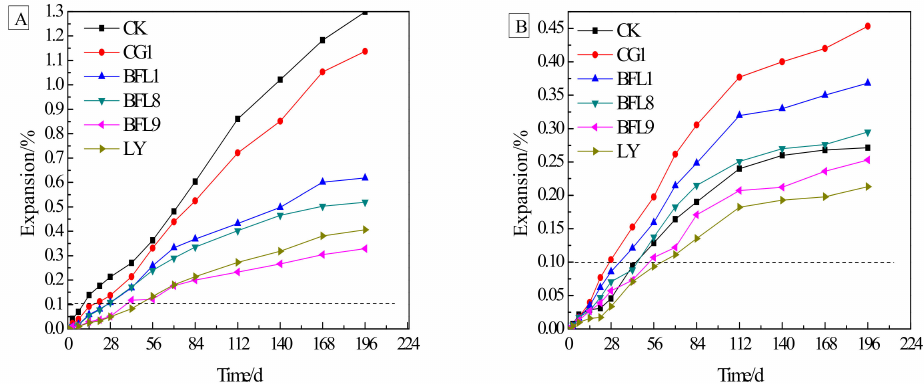
Figure 5. Expansions of concrete microbars: ( A ) concrete microbars cured in 1 mol / L NaOH at 80 ◦ C; ( B ) concrete microbars cured in 1 mol / L TMAH at 80 ◦